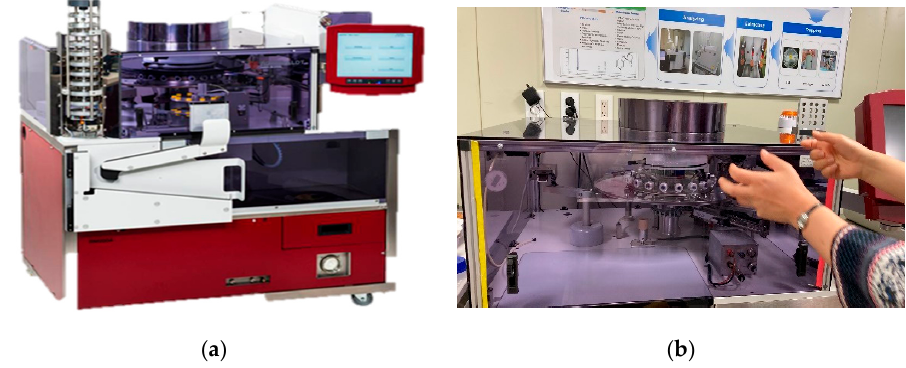
Figure 1. Rotary smoking machines ( a ) RM200A2 of BORGWALDT ( b ) Operation of Smoking Machine RM200A2 (in Seoul, Korea).